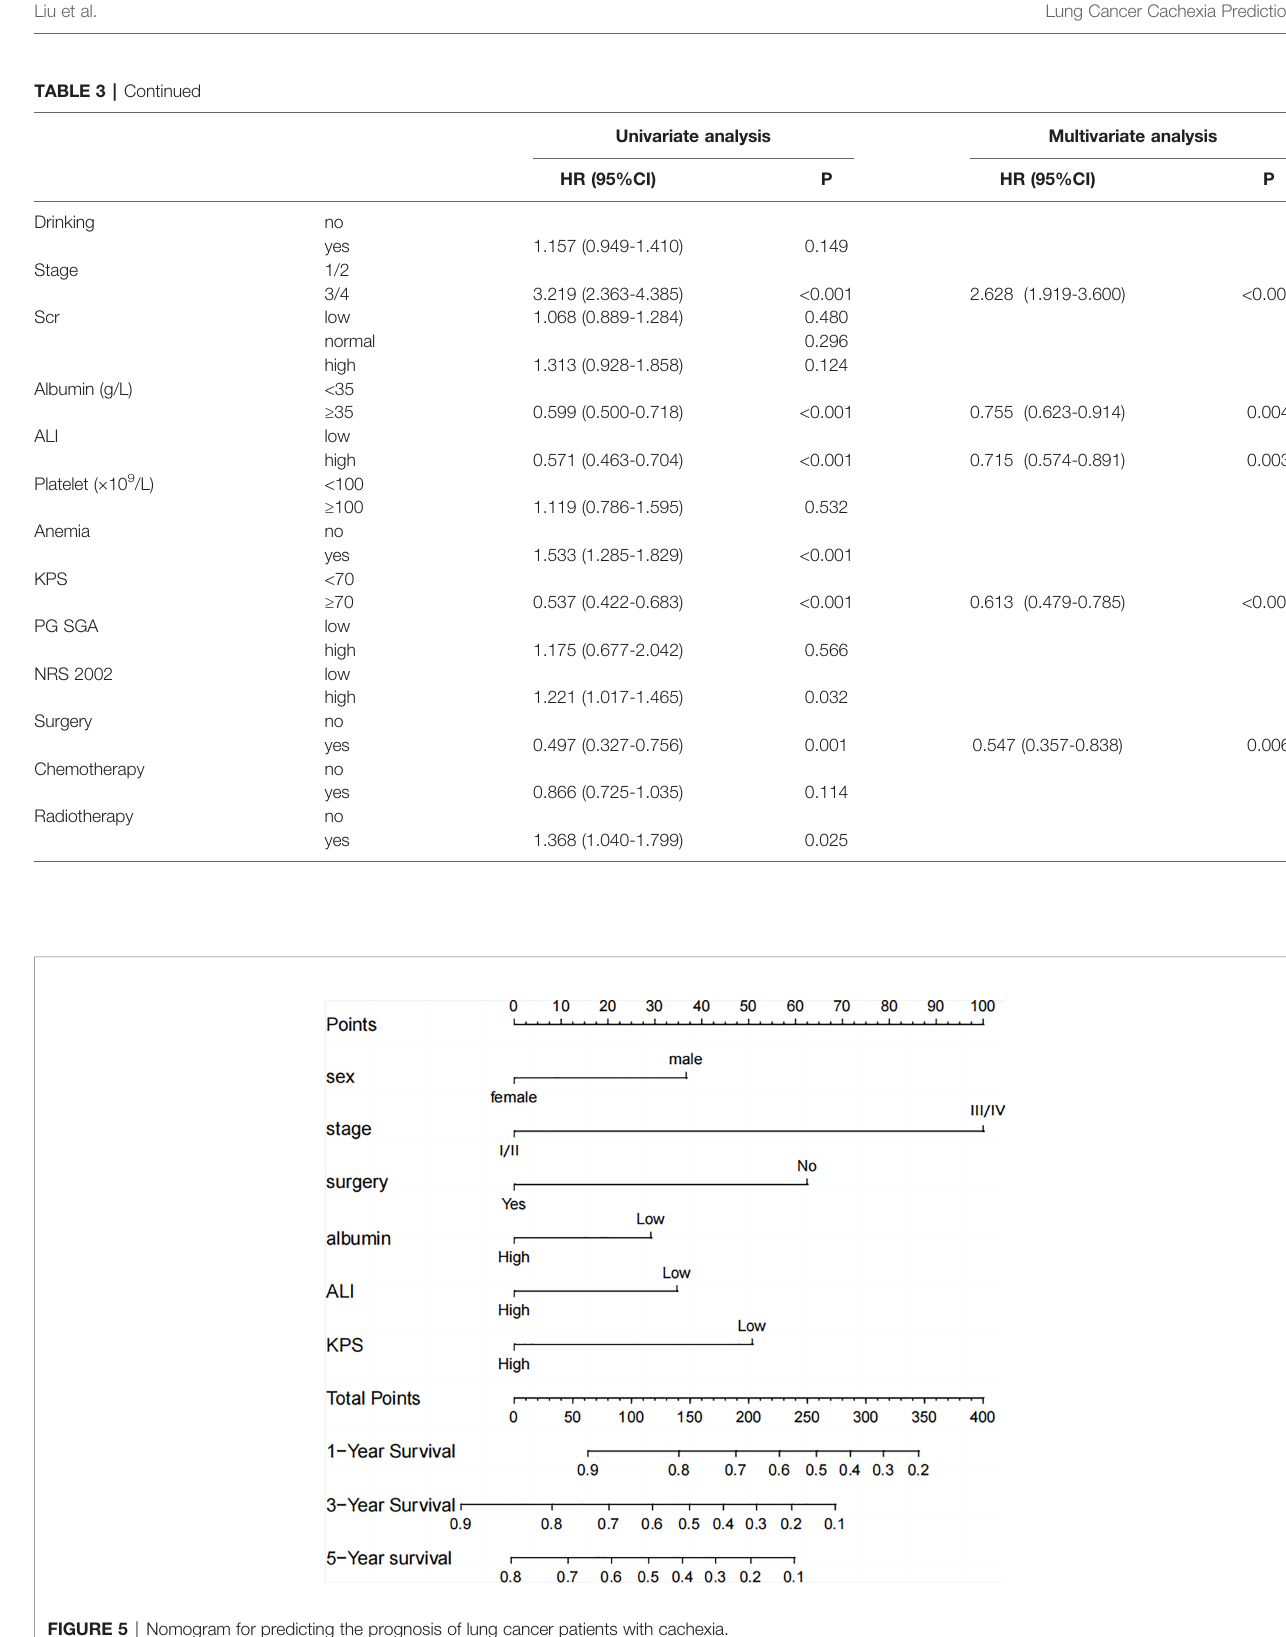
FIGURE 5 | Nomogram for predicting the prognosis of lung cancer patients with